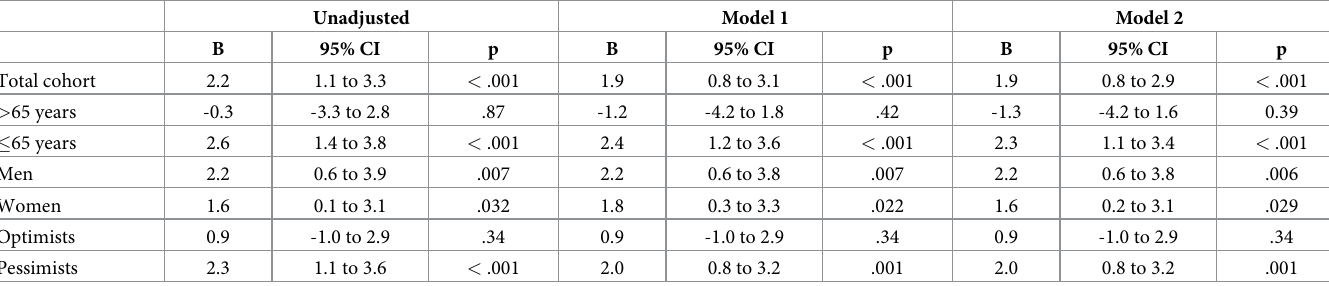
Table 3. Association between life event stress (score > Q3 vs � Q3) and depressive